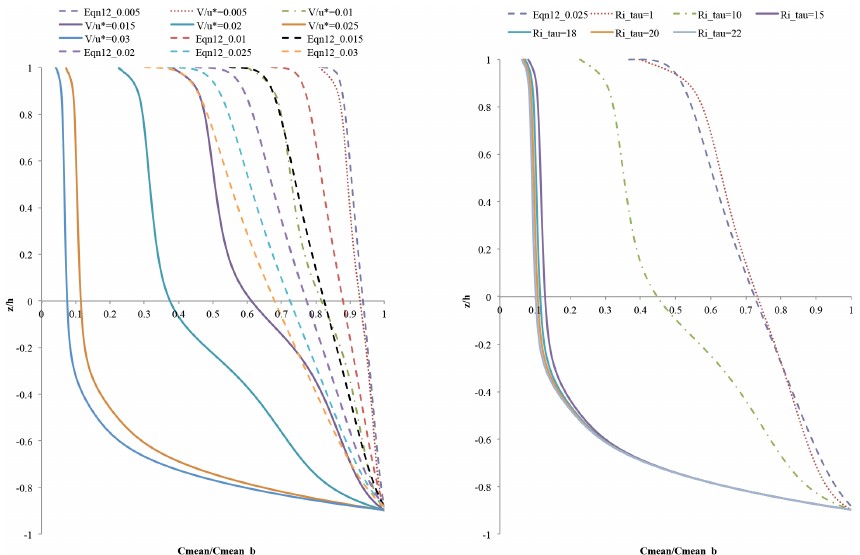
Figure 6. Normalized sediment concentration profiles from DNS simulations of the channel flow have been plotted with the sediment profile obtained using Eq. (12). The results from the DNS simulations matched very well with the derived relationship (Eq. 12) for relatively lower stratification ( ˜ V Ri τ < 0 . 1).